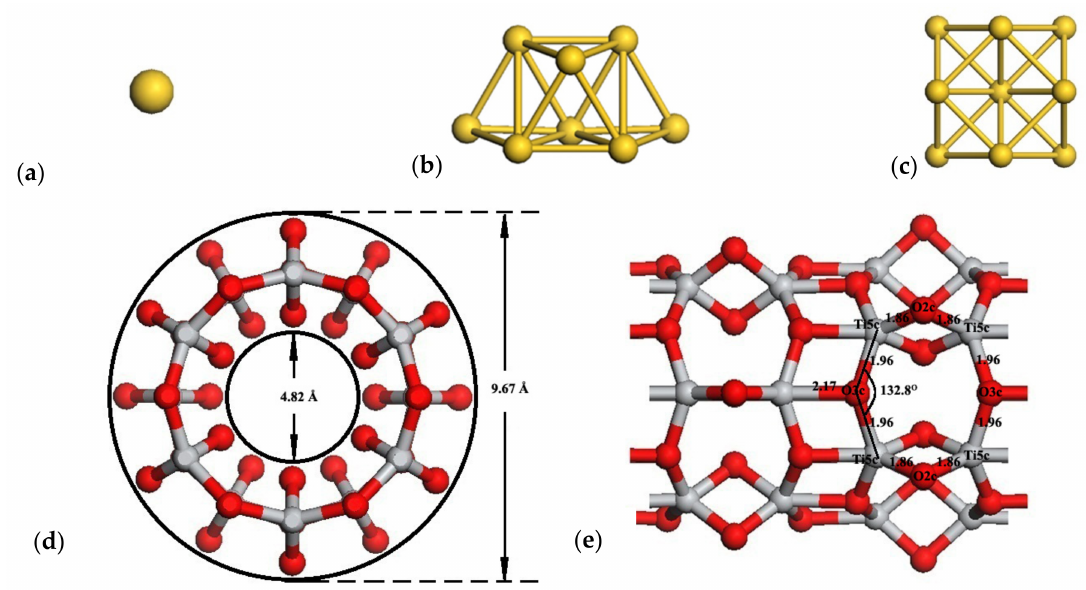
Figure 1. Optimized geometry of bare Au clusters and the bare TiO 2 NT (6,0). The first three configurations are: ( a ) Au 1 ; ( b ) Au 8 biplanar; ( c ) Au 13 cuboctahedral. ( d , e ) are the cross-sectional and the side view of the TiO 2 NT (6,0), respectively. The gold atoms are shown in gold, the oxygen atoms are displayed in red, while titanium atoms are presented in light